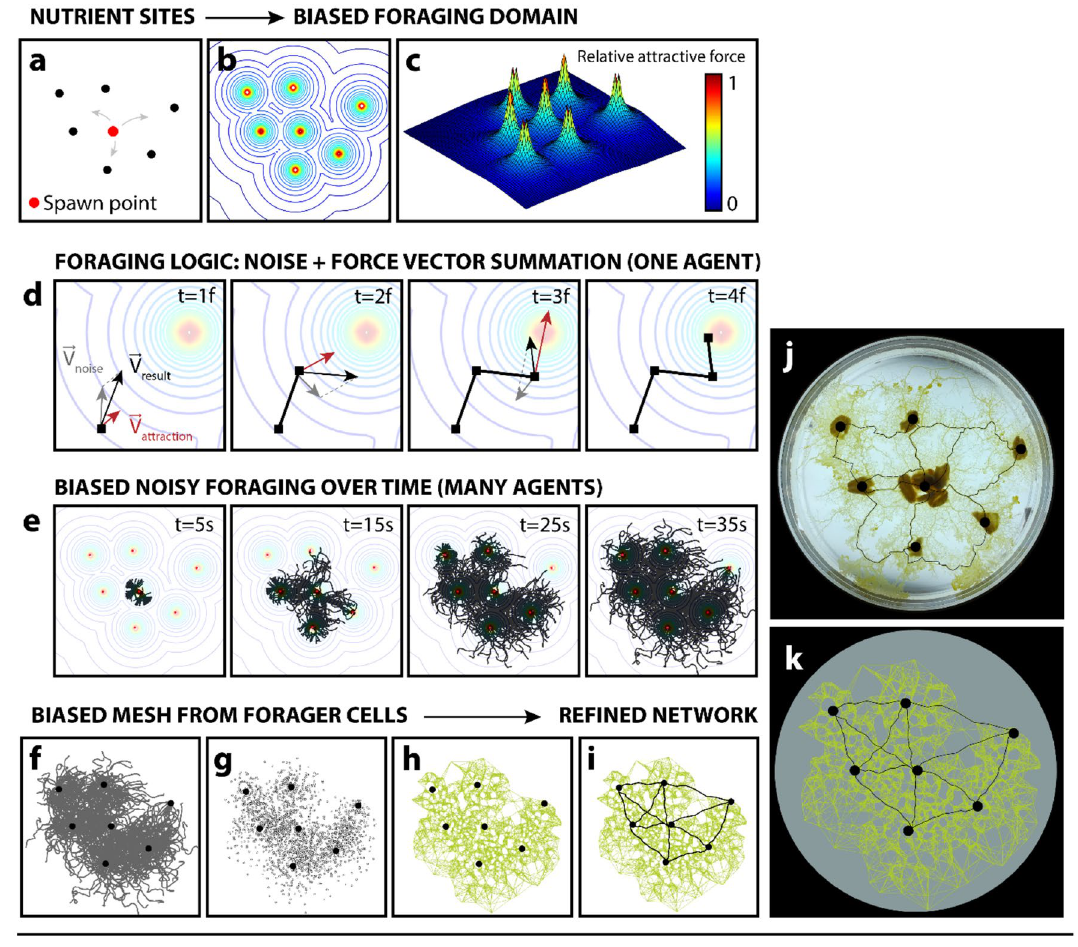
Figure 3. Modelled Physarum growth logic. ( a ) Plot showing seven reference food sources. ( b ) Contour plot of the force field generated from ( a ). ( c ) Surface topography showing relative attraction force intensity of ( b ). ( d ) Illustrated foraging logic for a single agent. At each frame, the noise vector is summed with the attraction vector, generated as a function of proximity to food source. ( e ) Screen captures of agent-based model growth over time until all food sources have been colonized. ( f ) Final agent path geometry, from t = 35 s. ( g ) Point cloud from paths in ( f ). ( h ) Mesh generated from points in ( g ). ( i ) Shortest-walk calculation to produce refined network from mesh in ( h ). ( j – k ) Biological versus modelled mesh growth with overlaid network for equivalent reference food